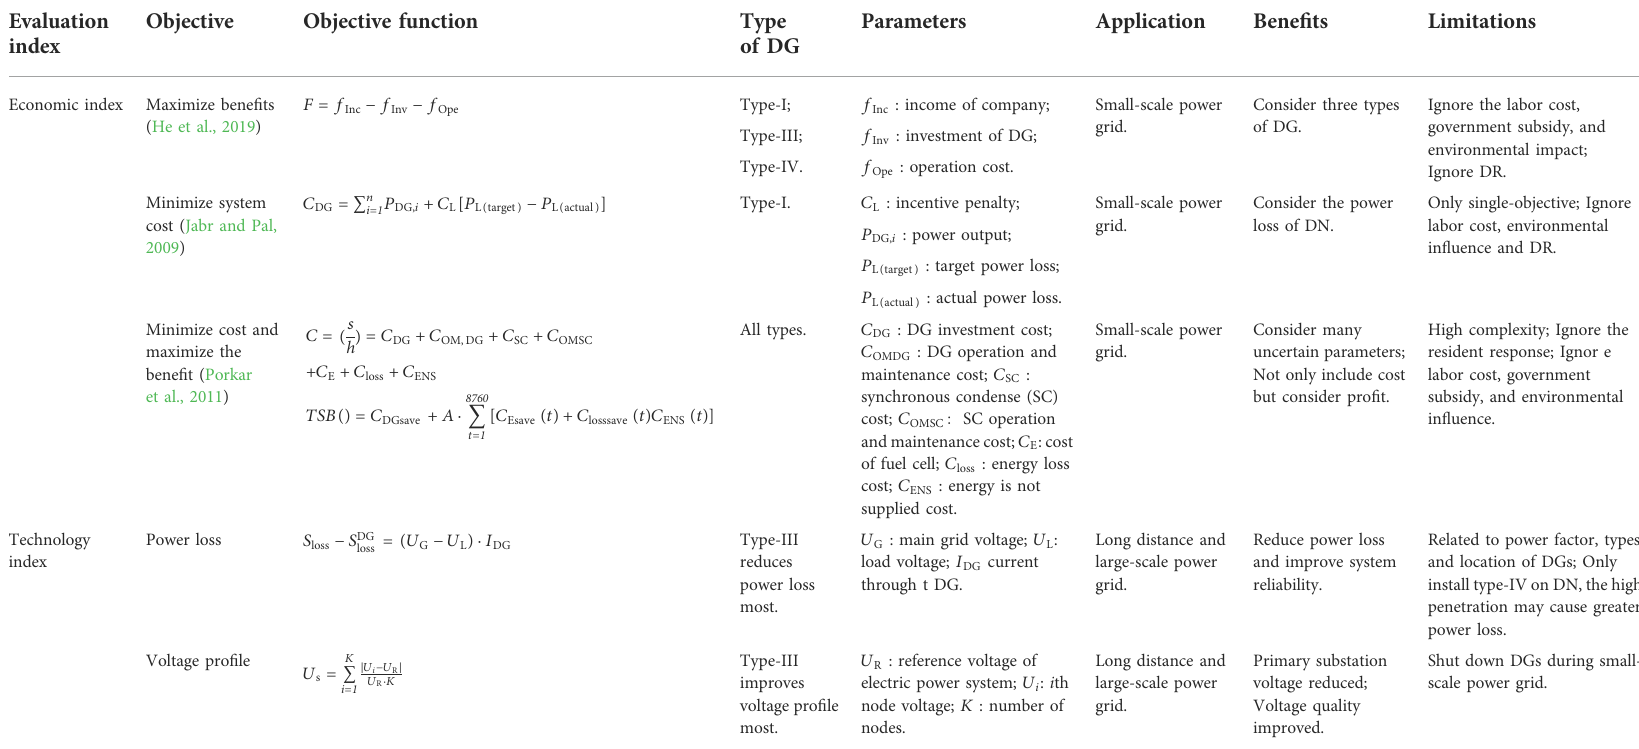
TABLE 1 Summary and analyze the evaluation indexes of